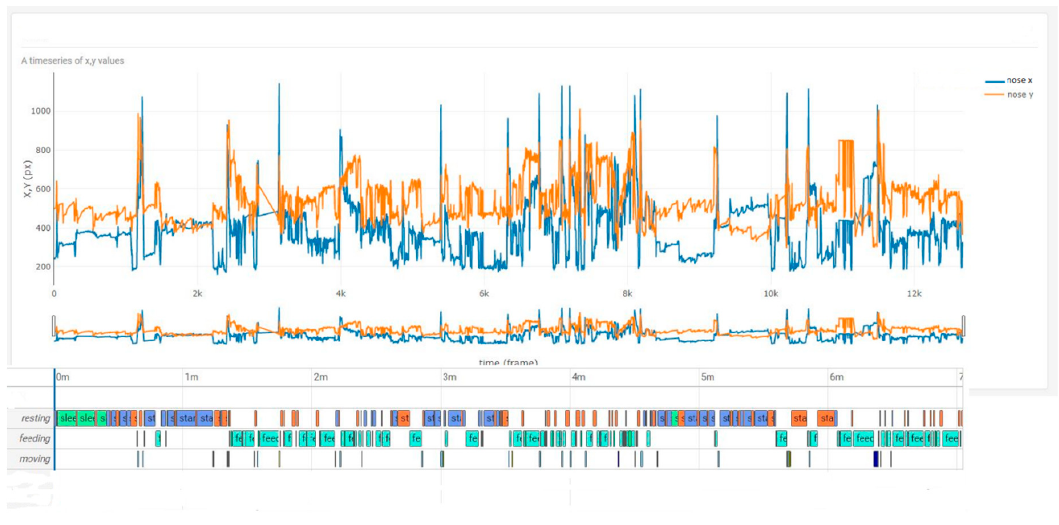
Figure 5. x, y time series plus behaviour score of the horse on day 8 post colic surgery. Weight shifting and extension of the forelimb was less frequent but still Figure 5. x,y time series plus behaviour score of the horse on day 8 post colic surgery.